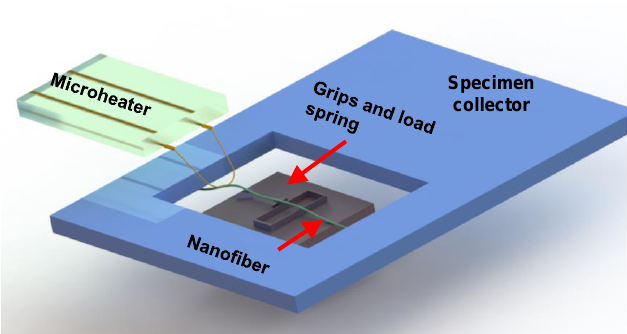
Figure 5. Schematic of alignment of the NF along the platform grips (figure not to scale). Adapted from reference [3] supplementary information. Actuators 2018 , 7 , 71